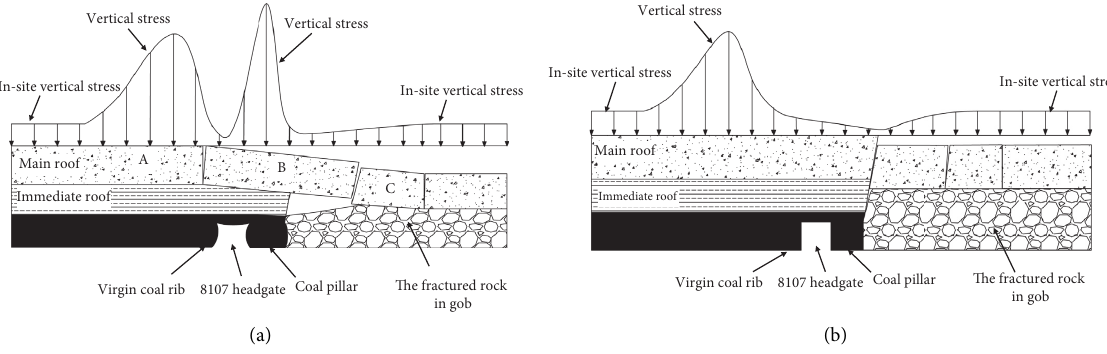
Figure 15: Failure analysis of surrounding rock in roadway. (a) Before roof fracturing. (b) After roof fracturing.